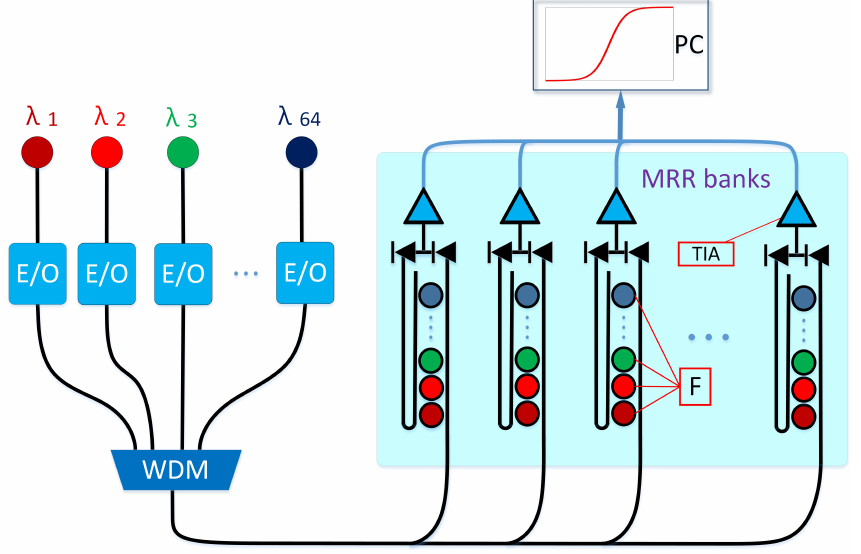
Figure 3. The optical backpropagation network architecture. λ represents different wavelengths. EO represents electro-optic modulators. WDM, wavelength division multiplexing. MRR banks consist of multiple add-drop MRRs in parallel. PD, detector. TIA, amplification. PC, digital